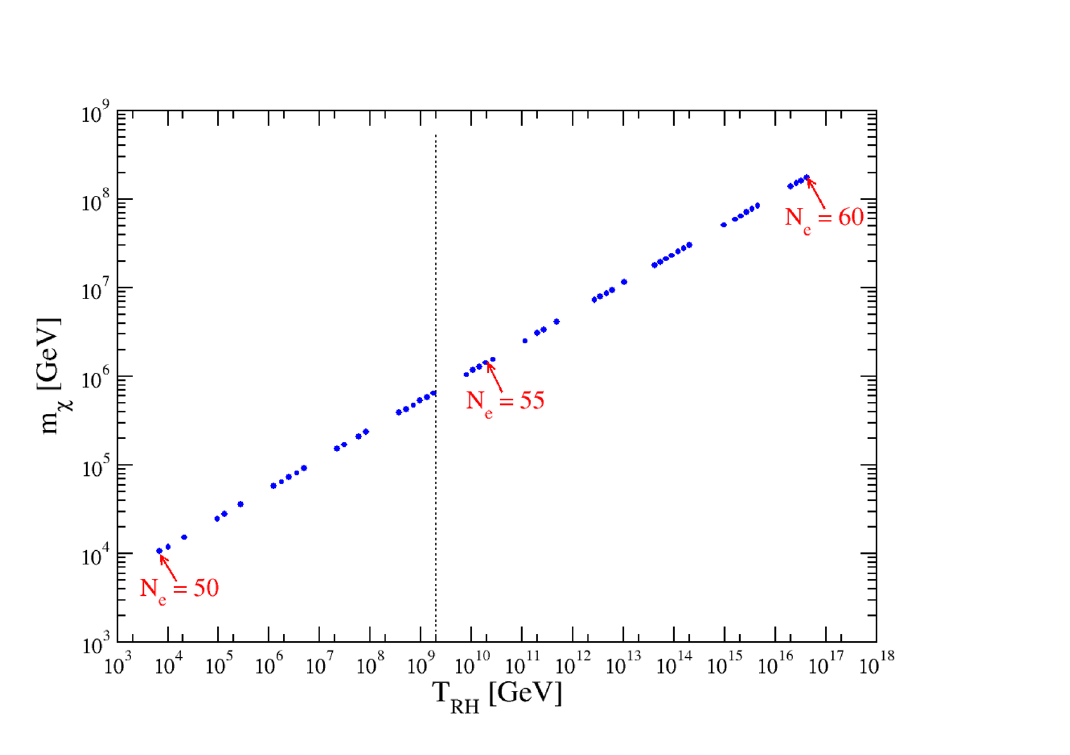
Figure 5 . Dark matter mass m χ against reheating temperature T RH . We have varied β S around the value 5 . 69 × 10 2 of benchmark point 2 (see table 1), while all the other input parameters are fixed to the benchmark point values. The result is found to be quite insensitive against the change of these parameters. The black dotted line shows the lower bound on T RH for a viable thermal leptogenesis with m N & 2 × 10 7 GeV [124].